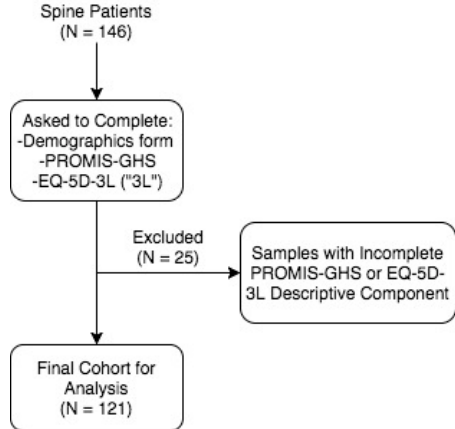
Figure 1. Sample Selection. PROMIS-GHS: Patient-Reported Outcomes Measurement Information System Global Health Survey; 5Q-5D: EuroQol 5-Dimension; 5Q-5D-3L; EQ-5D three-level survey.